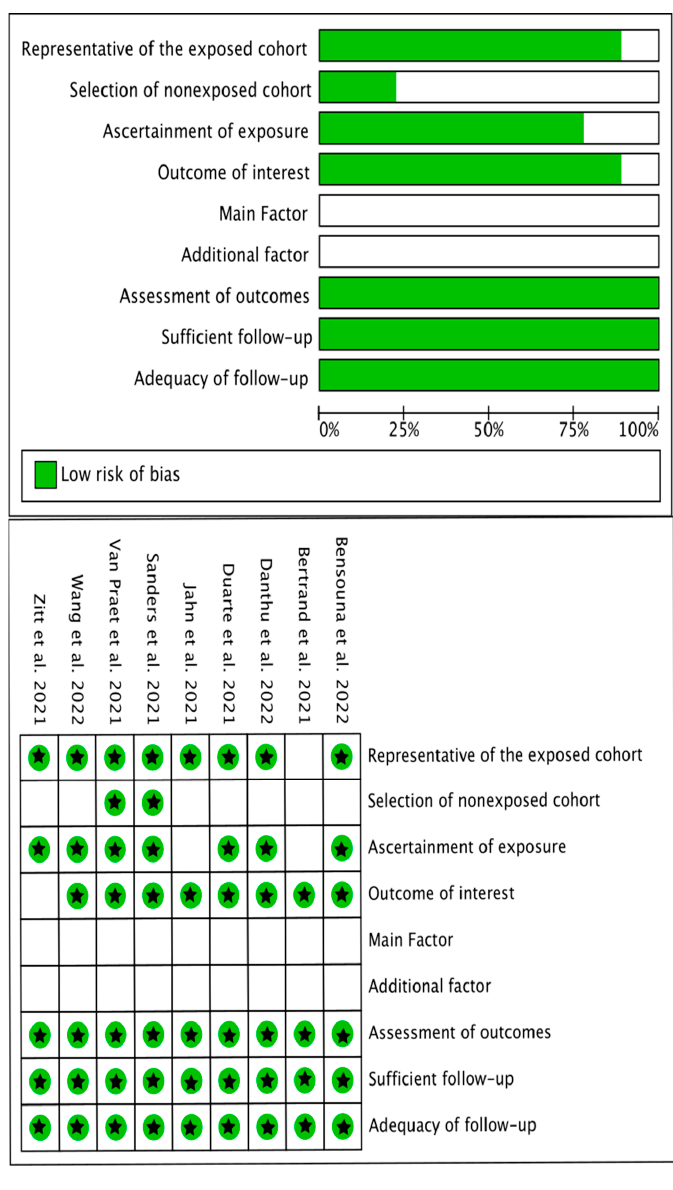
Figure 2. Methodological quality of those studies investigating humoral response in patients receiving hemodialysis after mRNA COVID-19 vaccine.